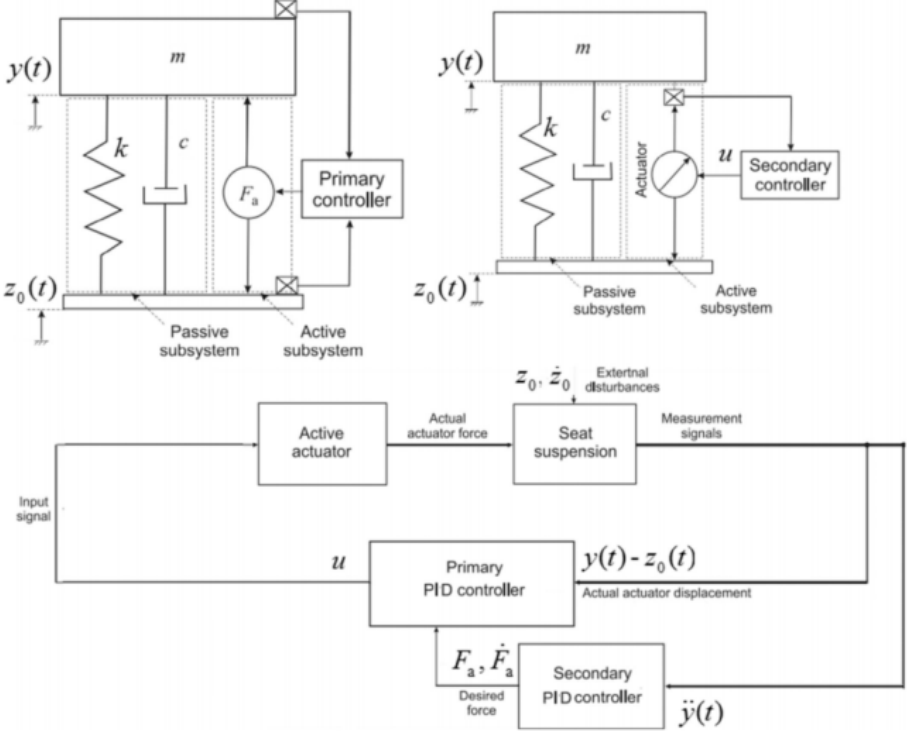
Figure 21. Block diagram of the proportional-integral-derivative (PID) control system [68].